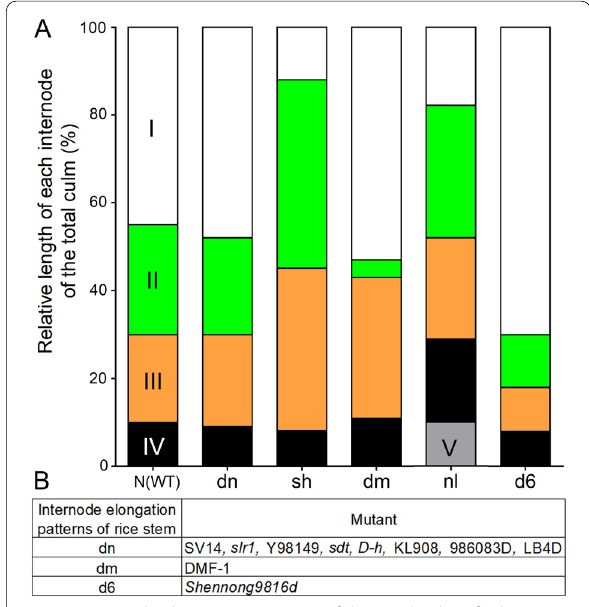
Fig. 1 Internode elongation patterns of the newly identified mutants. A Schematic diagram of internode elongation patterns of rice stem (redrawn from Takeda 1977). I: the first internode, shown in white block; II: the second internode, shown in green block; III: the third internode, shown in orange block; IV: the fourth internode, shown in black block; V: the fifth internode, shown in grey block. B The newly identified mutants with different internode elongation